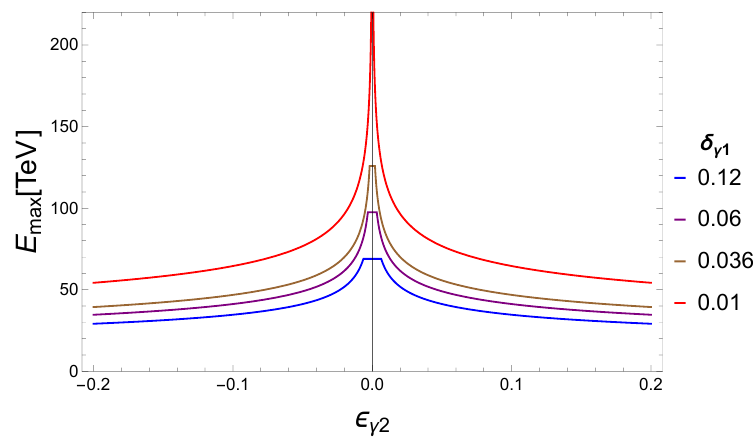
Figure 7 . The unitarity-violating scale from processes that depend on both δ γ 1 and δ γ 2 as function of the fractional deviation (cid:15) γ 2 from the predictions of the dim-6 SMEFT operator. See eqs. (3.13) and